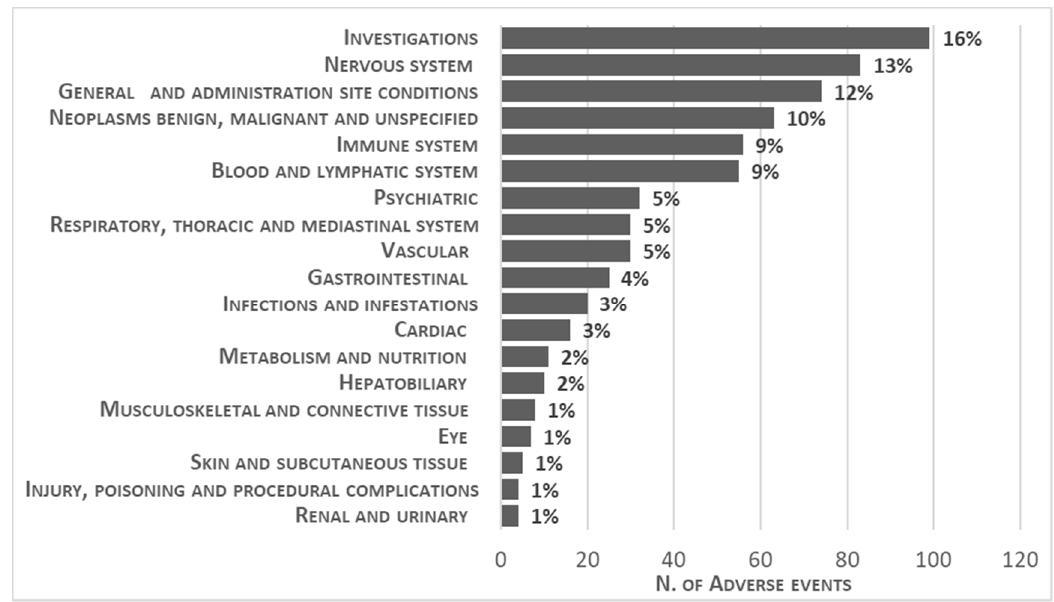
Figure 1. Distribution of System Organ Class related to each adverse event ( n = 638) reported in overall tisagenlecleucel paediatric Individual Case Safety Reports. Product issue, surgical procedures and disorders involving ear and endocrine systems have been not included in the figure because they accounted for less than 1% of the ICSRs.